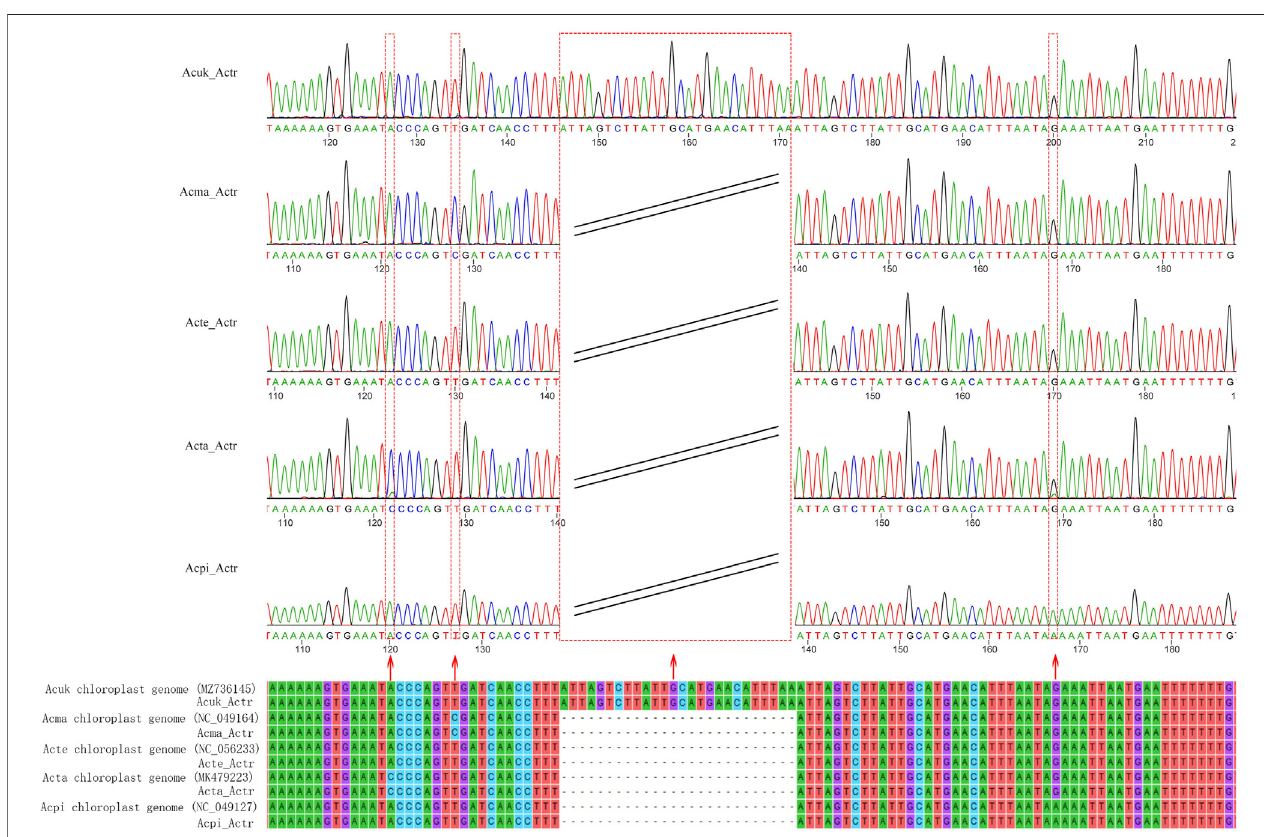
FIGURE 10 | Alignment of the sequences of the PCR products ampli fi ed using the primer of Acer TS and the reference sequences. The red arrows indicate SNPs, Indel loci, and their corresponding peaks. Acuk: A. ukurunduense ; Acma: A. mandshuricum ; Acte: A. tegmentosum ; Acta: A. tataricum ; Acpi: A. pictum .